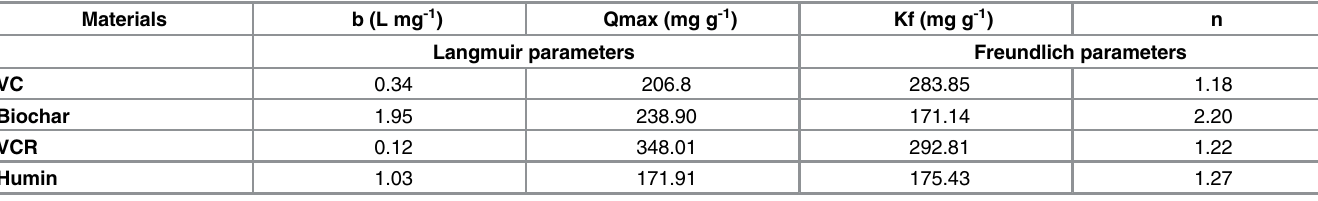
Table 1. Adsorption parameters obtained from Freundlich and Langmuir isotherms.